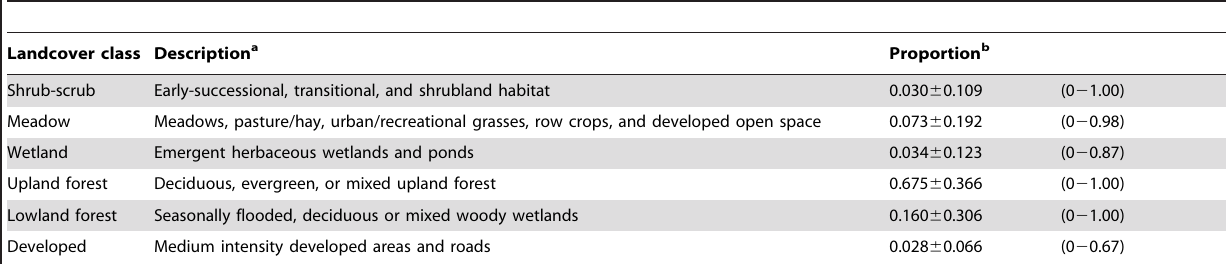
Table 1. Landcover proportions within 100 m of 316 point-count locations throughout the Patuxent Research Refuge, Laurel, Maryland,